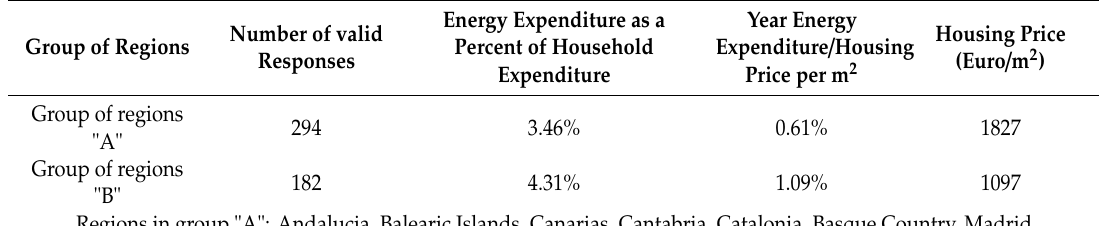
Table 3. Grouping of